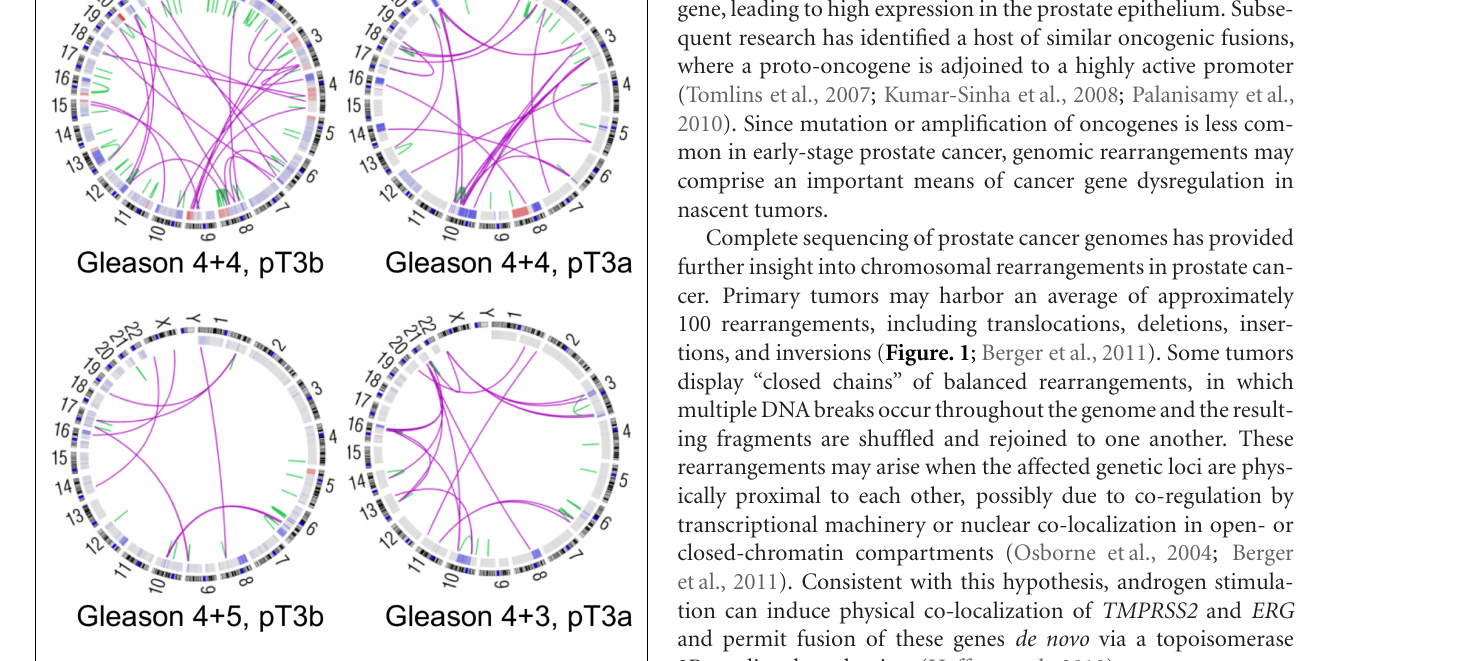
FIGURE 1 | Genomic alterations in four high-risk prostate cancers. Circos plots depicting genomic rearrangements and copy number alterations in four prostate tumors analyzed by whole-genome sequencing (unpublished data). Green and pink lines designate intrachromosomal and interchromosomal rearrangements, respectively. Somatic copy number alterations are indicated in red (amplification) and blue (deletion) in the inner rings. Gleason scores indicate the two most prevalent histologic grades in each tumor. Pathological stage is noted as well, where pT3 indicates locally invasive